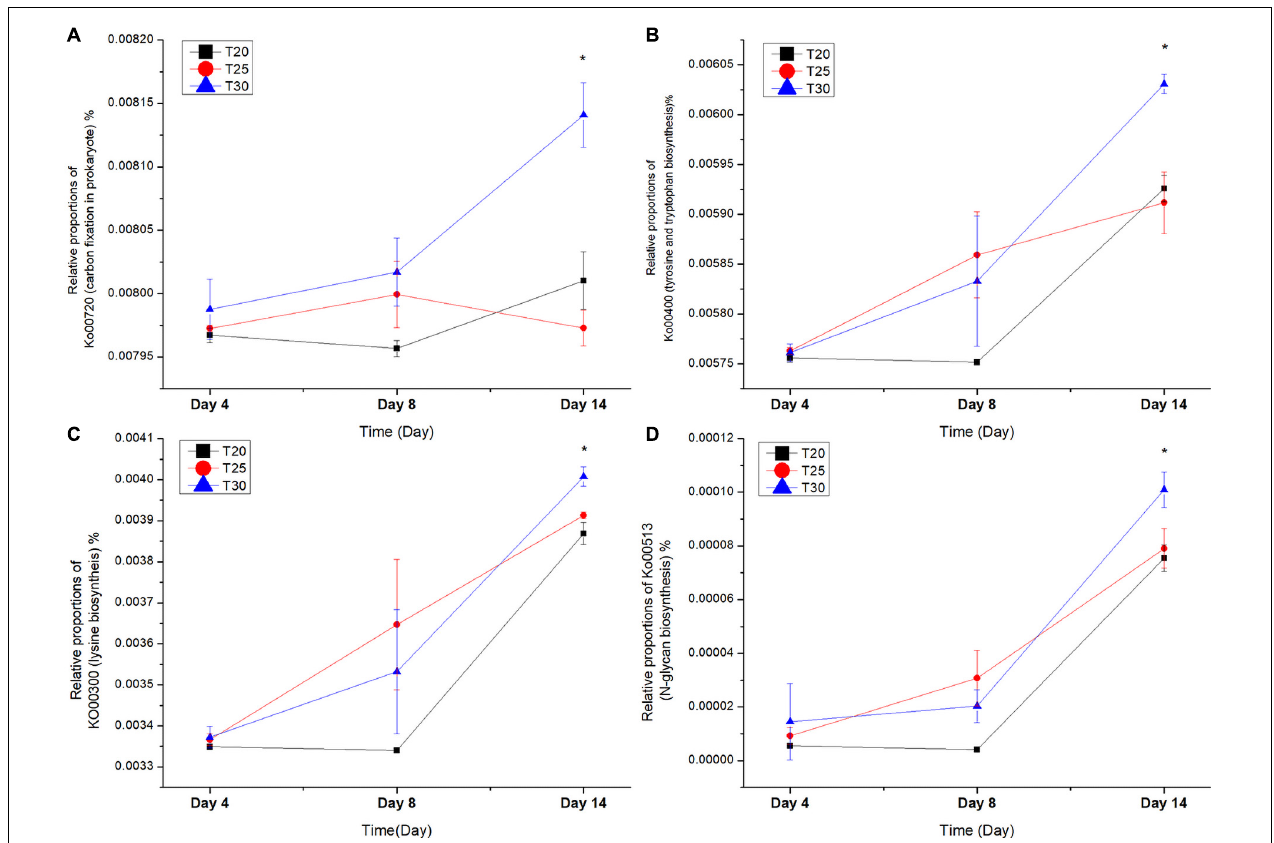
FIGURE 7 | The relative proportions of (A) Ko00720 (carbon fixation pathways in prokaryotes, (B) Ko00400 (phenylalanine, tyrosine and tryptophan biosynthesis), (C) Ko00300 (lysine biosynthesis), (D) Ko00513 (N-glycan biosynthesis at different temperatures and time points). The one-way ANOVA method was used to perform the significance differences analysis. *Indicates significant difference between different treatments ( p <